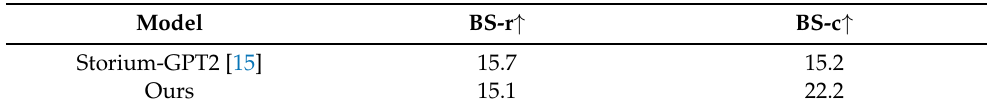
Table 3. BERTScore